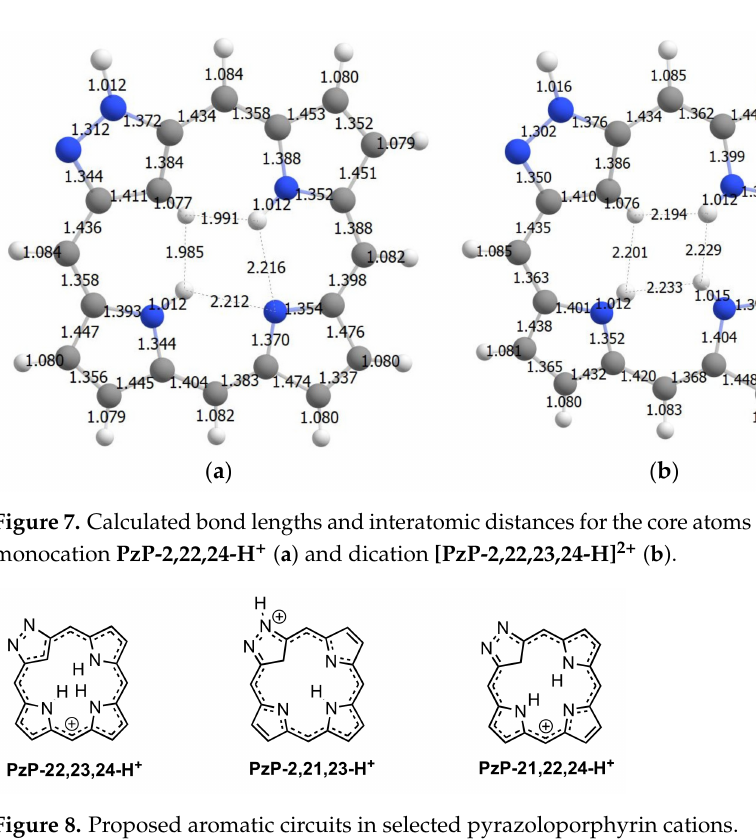
Figure 8. Proposed aromatic circuits in selected pyrazoloporphyrin cations. Table 5. Calculated Relative Energies (kcal/mol) and NICS Values (ppm) for Diprotonated Pyrazolo- porphyrin